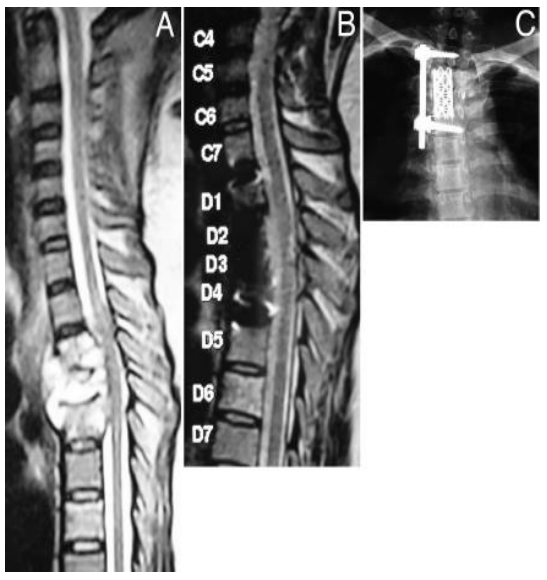
FIG. 2. Preoperative MR image (A), postoperative MR image (B), and postoperative radiograph (C) obtained in a patient presenting with spinal TB and severe deficits (Frankel Grade